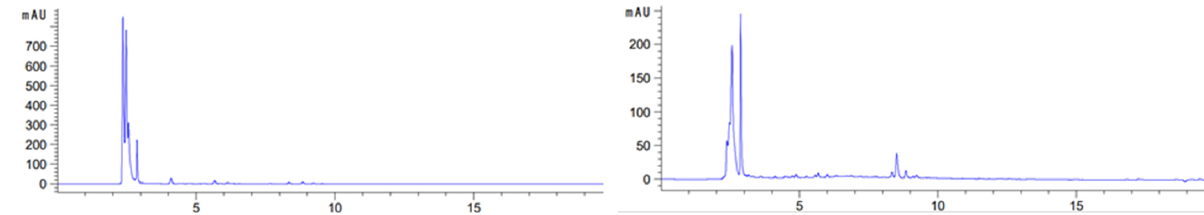
Figure 1. Polyphenolic profiles of minced meat product ( left ) and minced vegetarian product (meat analogue products) ( right ).